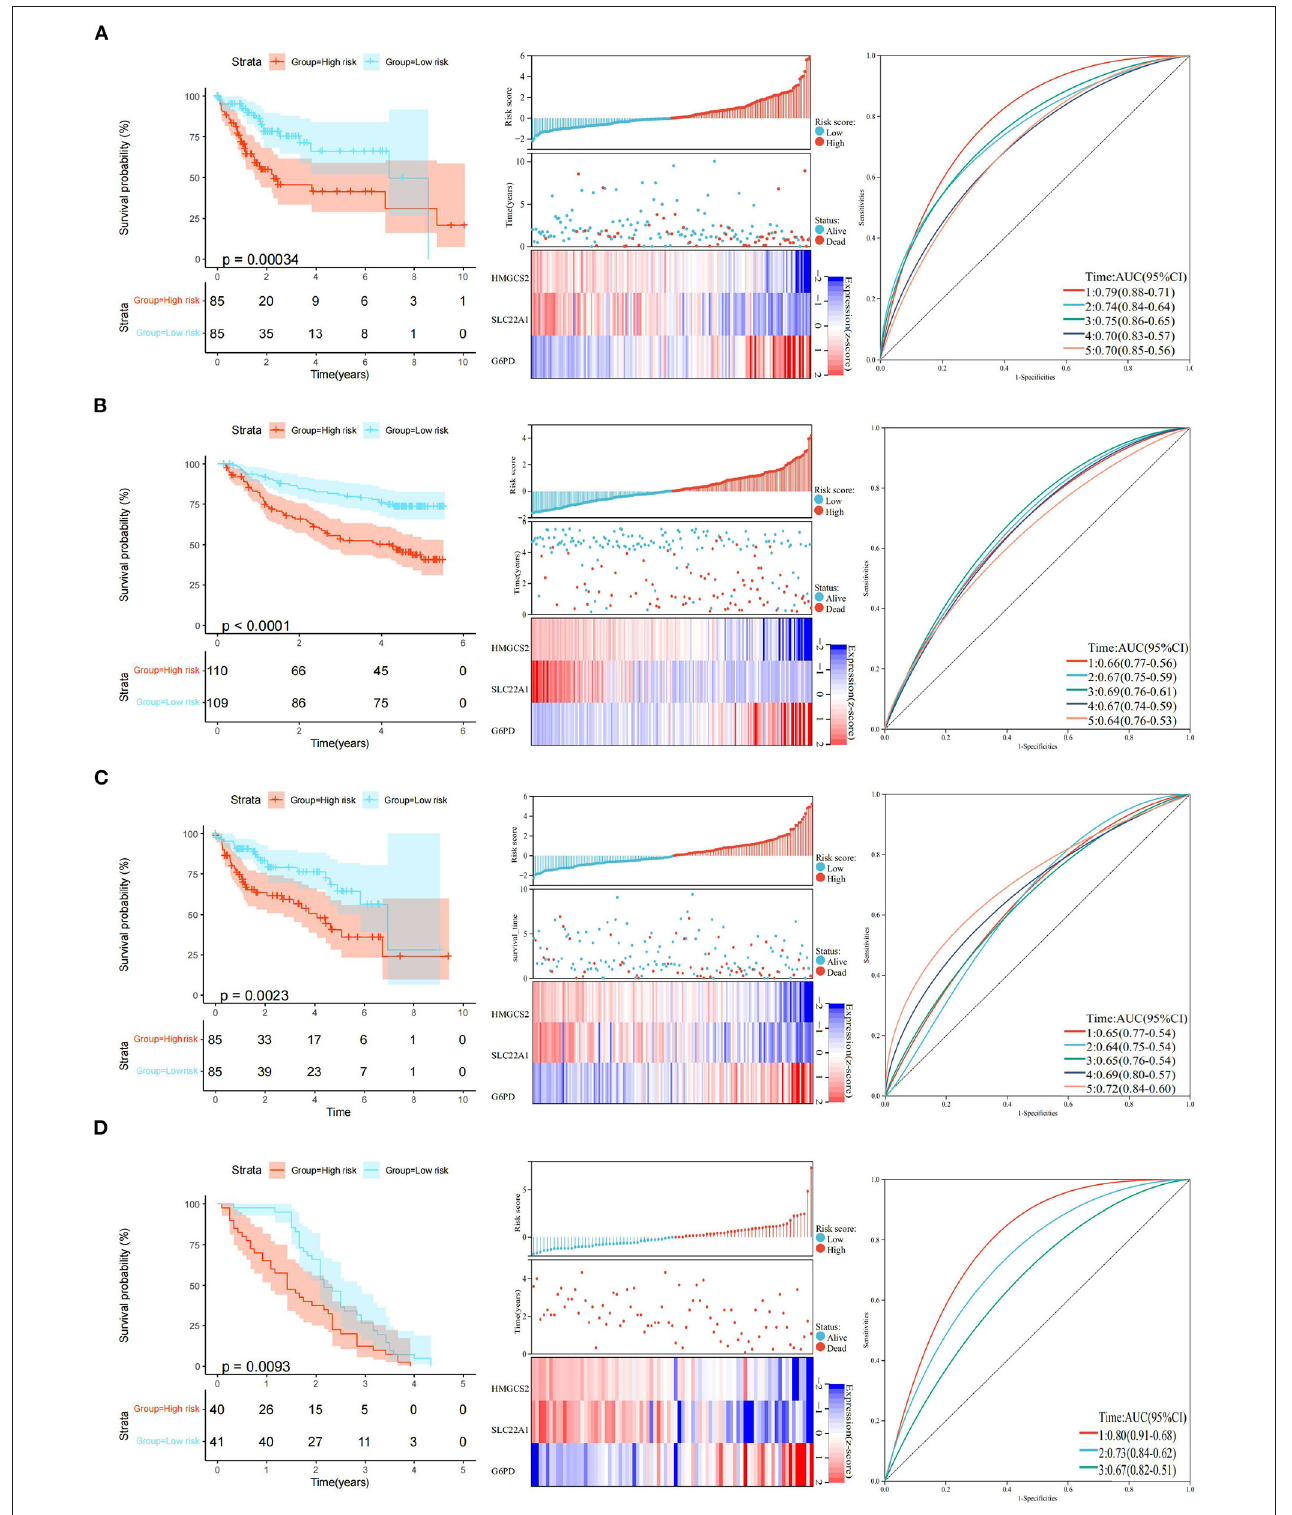
FIGURE 5 | Construction and validation of the 3-gene prognostic model. (A) KM curve analysis, distributions of high- and low-risk scores, and time-dependent ROC curve analyses of the TCGA training set. (B) KM curve analysis, distributions of high- and low-risk scores, and time-dependent ROC curve analyses in GSE14520. (C) KM curve analysis, distributions of high- and low-risk scores, and time-dependent ROC curve analyses of the TCGA validation set. (D) KM curve analysis, distributions of high- and low-risk scores, and time-dependent ROC curve analyses in GSE54236.